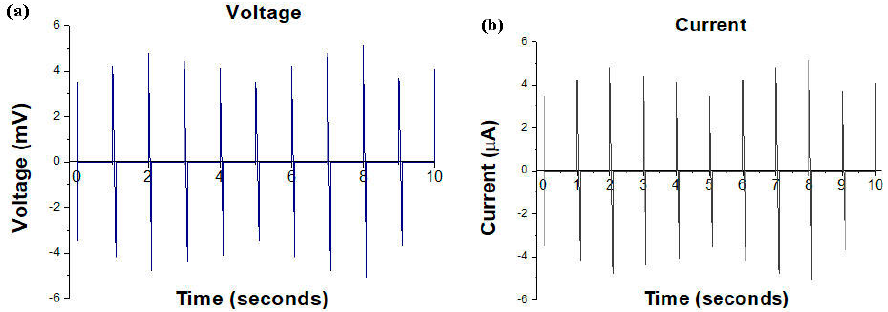
Figure 16. For 100 seconds: ( a ) Open circuit voltage; ( b ) short circuit current.